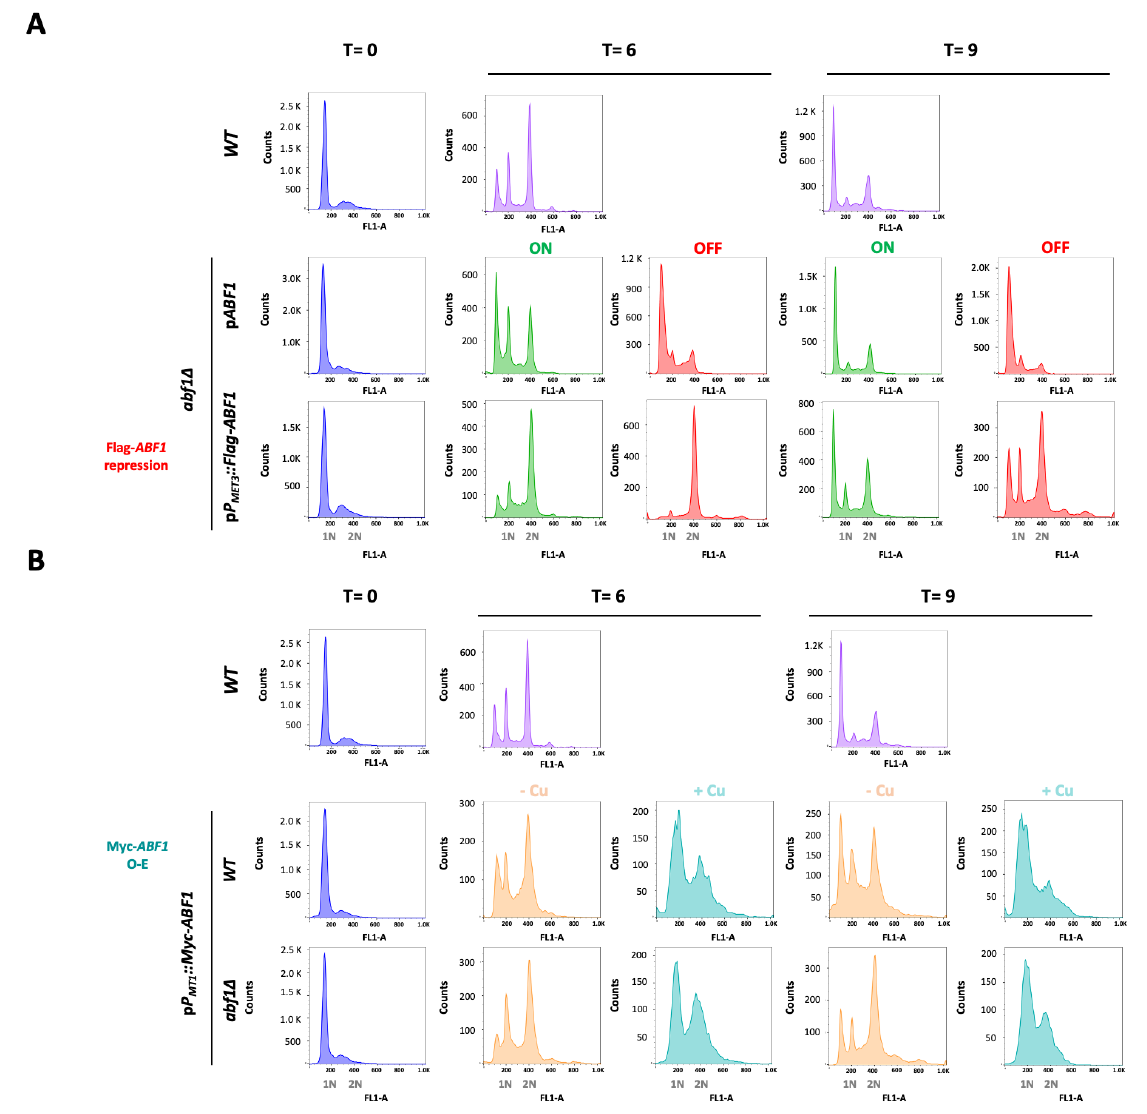
Figure 6. Absence or overexpression of CgAbf1 causes defects in the cell cycle progression. Stationary phase (SP) cells (T = 0) grown in YNB minimal medium were adjusted to an OD 600 0.5 in ON (in green, YNB minimal media); OFF (in red, YNB + 0.2 mM each cys and met),—Cu (Orange, YNB minimal media) or + Cu (teal blue, YNB + 25 µ M CuSO 4 ) media, depending on the strain, and then incubated 9 h at 30 ◦ C. Samples were taken every three hours and stained with SYTOX™ Green for DNA content analysis by Flow Cytometry (FACS). Representative histograms for DNA content quantification with SYTOX Green are shown; “Y” axis shows the cells count, “X” axis corresponds to the intensity of fluorescence signal from SITYOX Green. 1N and 2N marks in the “X” axis correspond to G1 and G2 DNA content. ( A ) From left to right, T = 0 h (in blue) corresponds to histograms from the indicated strains in SP. T = 6 h histograms show the DNA content after 6 h incubation of: WT strain (light purple), abf1 ∆ strain with the native ABF1 promoter p P ABF1 :: ABF1 , or shut-off plasmid (p P MET3 ::Flag-ABF1 ), in ON (green) or OFF (red) media. T = 9 h are the same as T = 6 h but after 9 h of incubation in each media. ( B ) Same as in A but using the overexpression plasmid as follows. From left to right, T = 0 (blue) histograms show the DNA content of strains from stationary phase cultures; T = 6 correspond to samples after 6 h of WT strain (light purple), strains with the overexpression plasmid (p P MT1 ::Myc-ABF1 ) in WT and abf1 ∆ backgrounds in—Cu (orange, non-inducing conditions) and + Cu (teal blue, inducing conditions) media. T = 9 same as T = 6 but after 9 h of incubation. To facilitate the comparison with the WT strain, these strain’s histograms were duplicated for panels A and B, as all the strains were run together in this experiment and the same WT culture served as a control for the rest of the strains and conditions. Experiments were performed three times and the histograms from a representative experiment are shown. Data were analyzed with the software